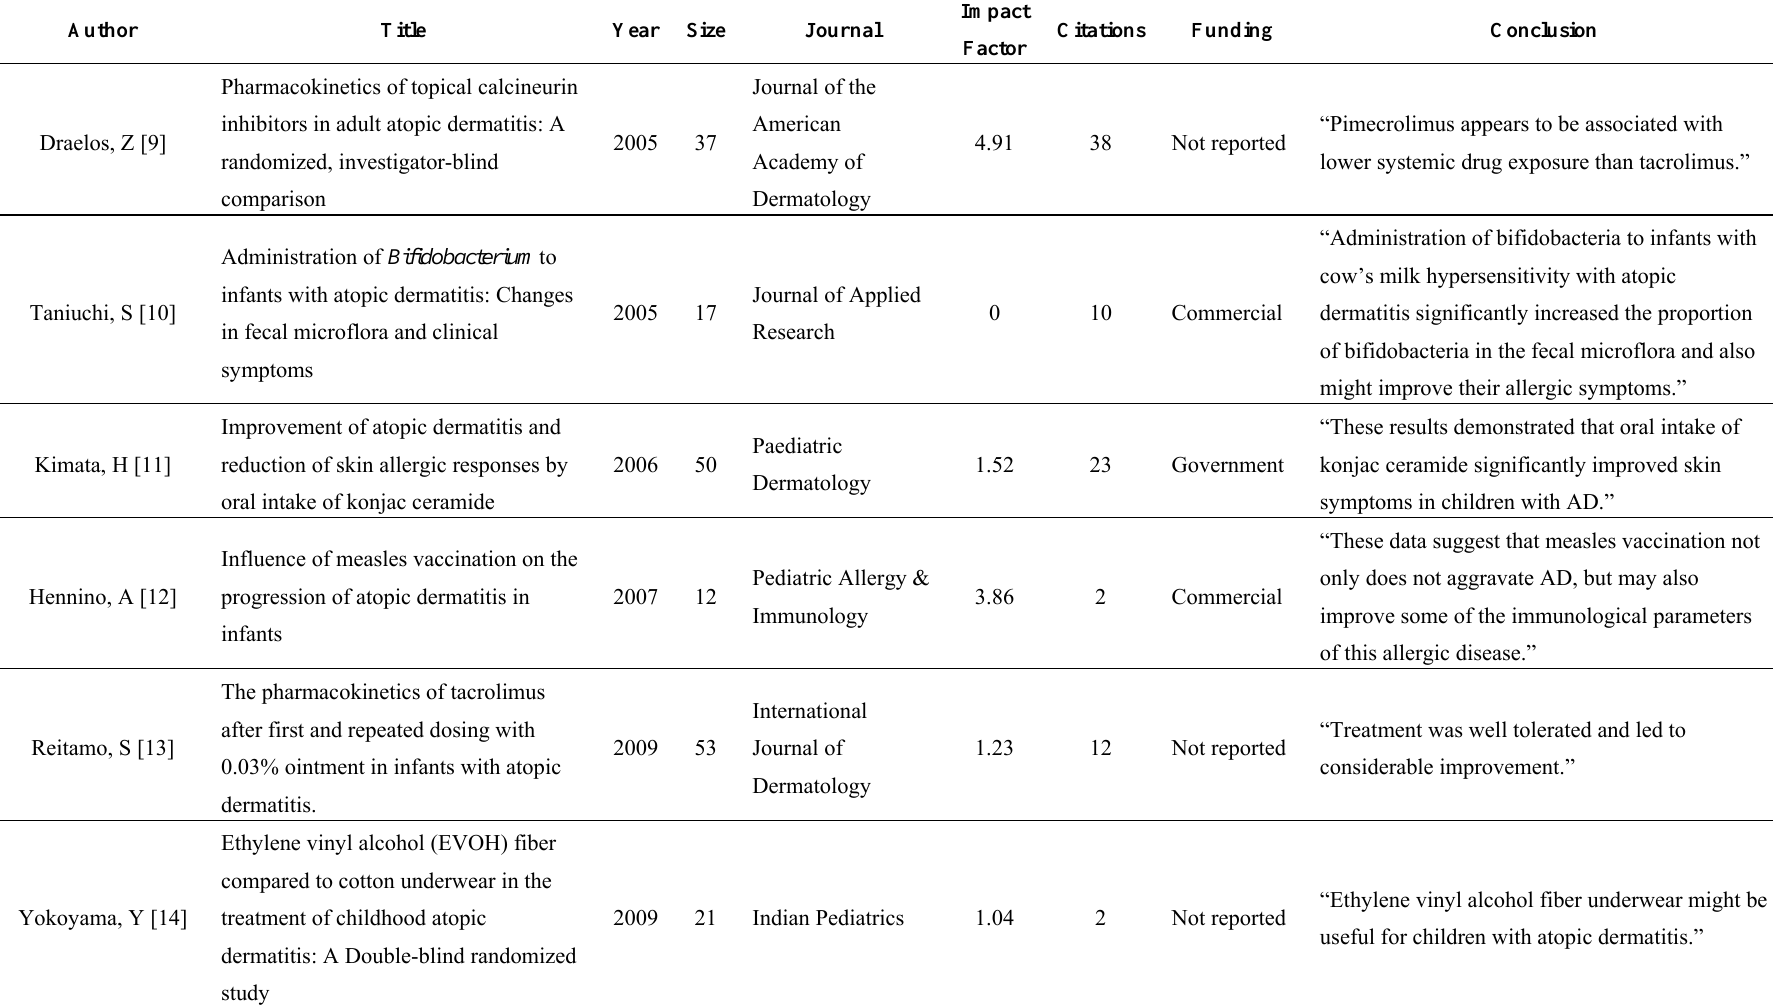
Table 2. Studies which failed to compare the